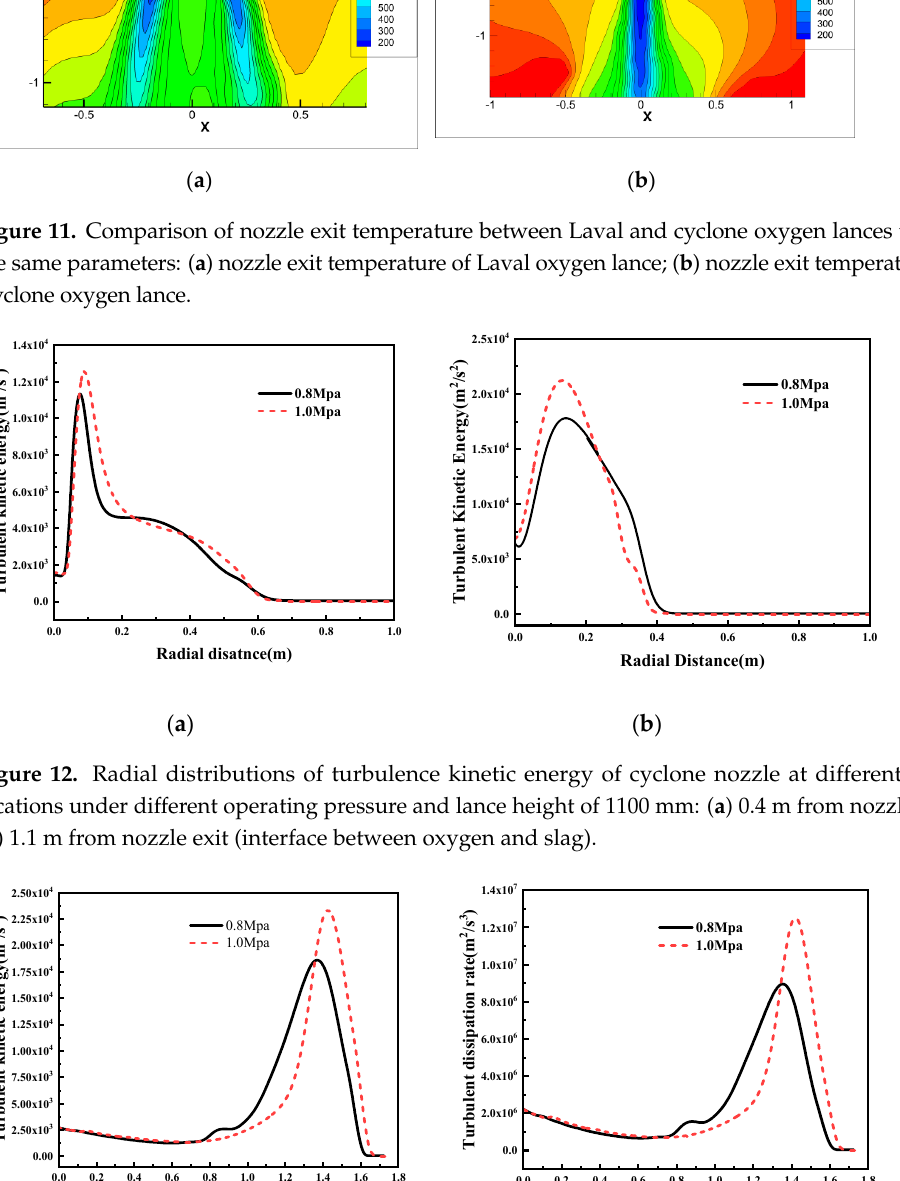
Figure 13. Axial distributions of turbulent kinetic energy and turbulent dissipation rate of cyclone nozzle under different operating pressure: ( a ) distributions of turbulent kinetic energy; ( b ) distribu- tions of turbulent dissipation rate.